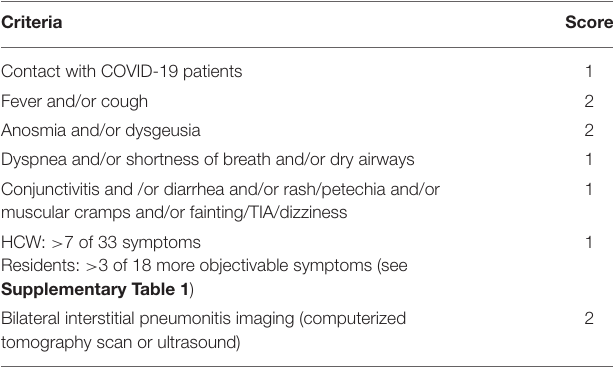
TABLE 3 | Clinical pre-test scoring of COVID-19 probability: a total score ≥ 2 is considered suspicious of infection, independently of negative tests. Criteria